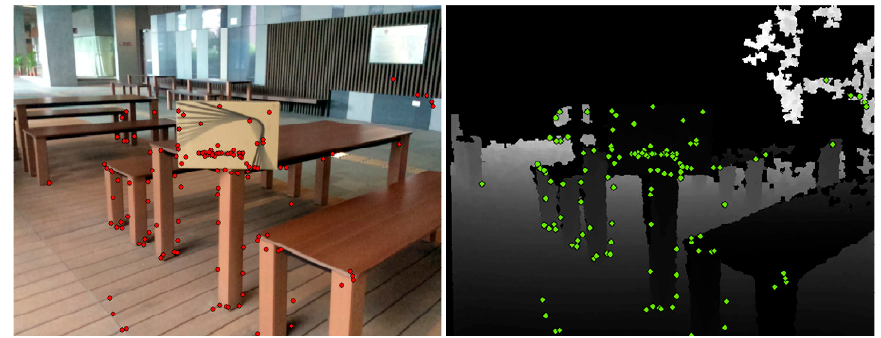
Figure 5. ( left ) Feature matches from an RGB image; and ( right ) feature matches on the corresponding depth image.